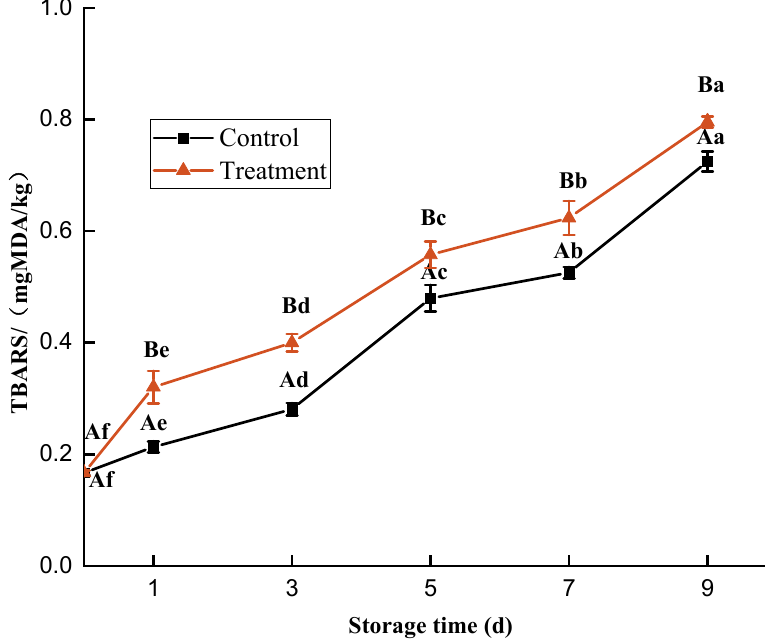
Figure 6. Changes in the TBA value of Trachinotus ovatus during refrigerator storage. Within the same group, different lowercase superscripts indicate significant differences ( p < 0.05). Among different groups, different capital letter superscripts indicate significant differences ( p < 0.05).